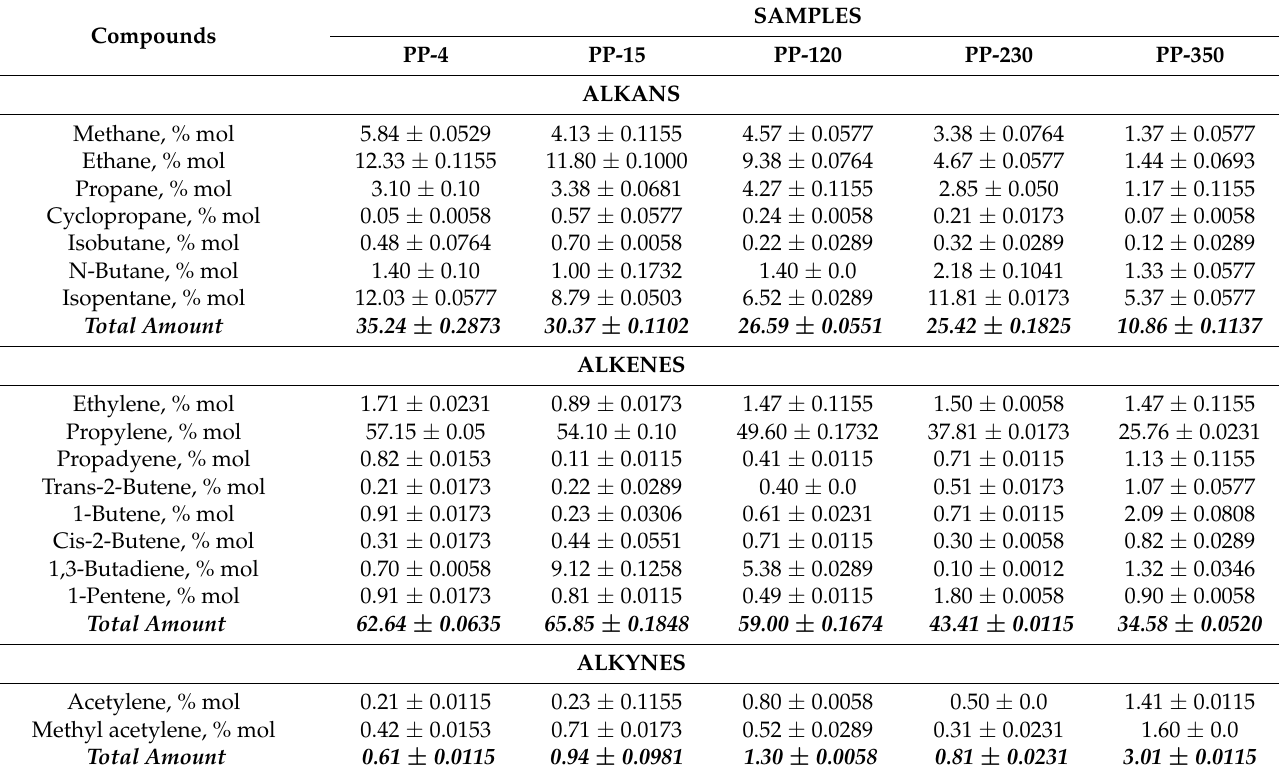
Table 2. The concentrations of the identified pyrolysis